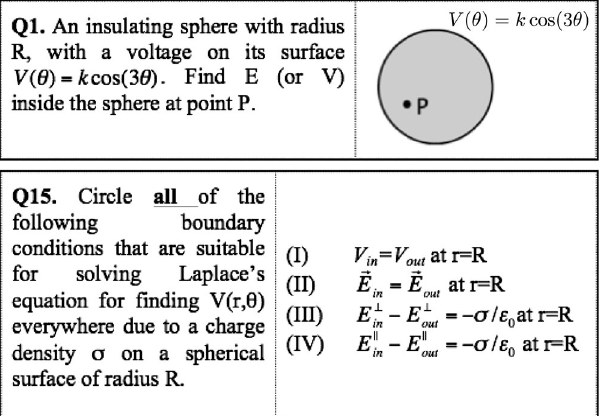
FIG. 6. Questions where the scores of OSU students differ significantly from the scores of students taught at CU. Repro- duced from the CUE